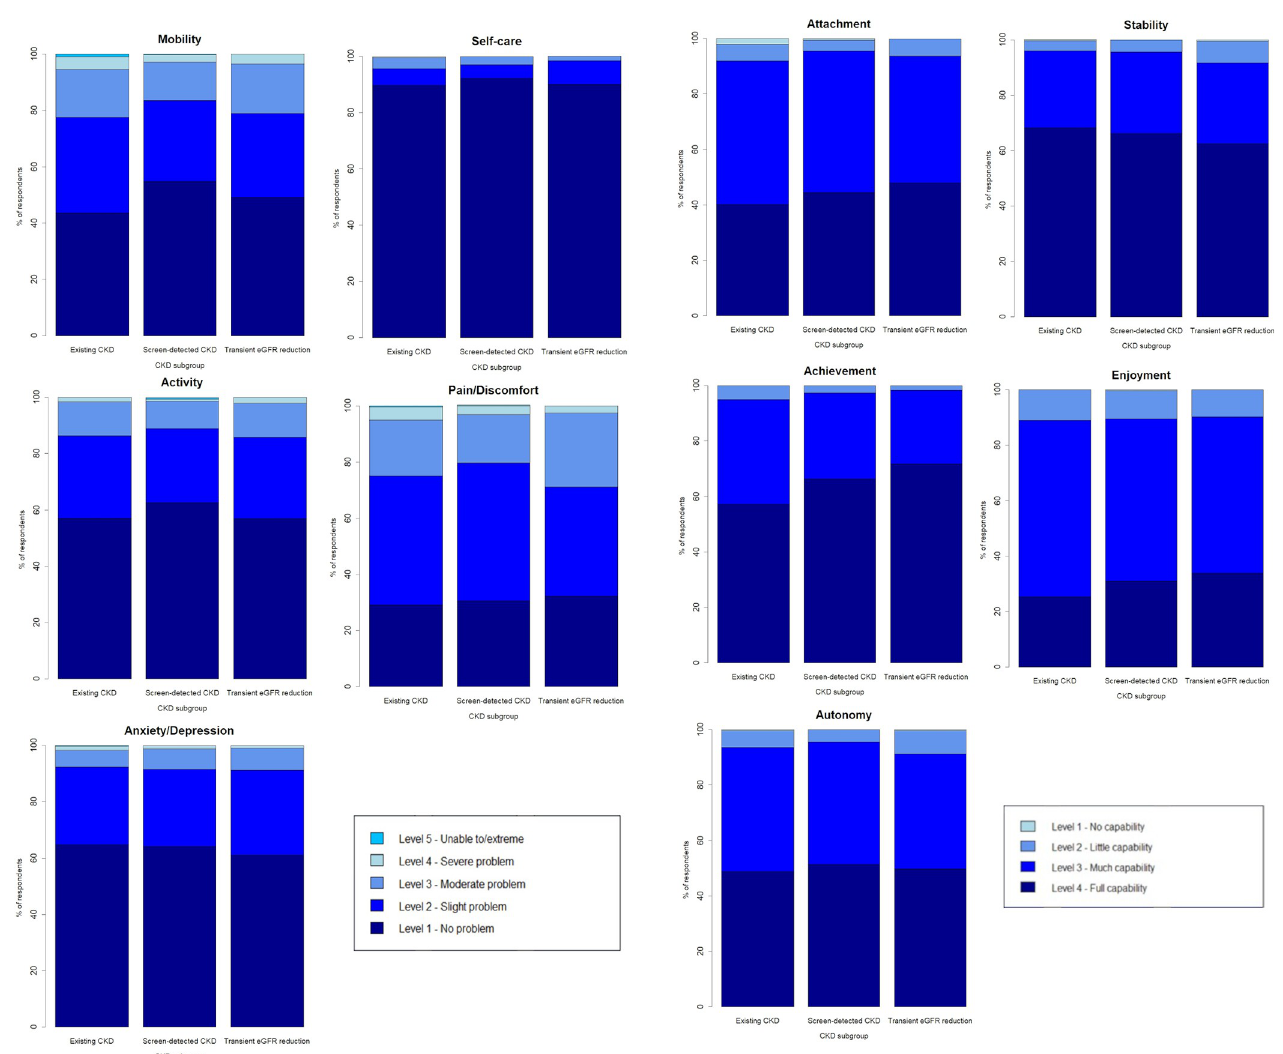
Fig 1. EQ-5D-5L (a) and ICECAP-A (b) questionnaire responses stratified by dimension. https://doi.org/10.1371/journal.pone.0275572.g001 Table 2 shows mean questionnaire scores for the three QoL questionnaires, stratified by CKD subgroup. Mean ( ± SD) EQ-VAS score for the CKD cohort was 79.2 ± 15.3; there was no statistically significant difference between the subgroups in ANOVA testing (p = 0.78), non- parametric testing (p = 0.83), and logarithmic transformation of questionnaire scores (p = 0.91). There were also no significant differences between CKD subgroups in QoL scores combining all dimensions for either EQ-5D-5L or ICECAP-A questionnaires.